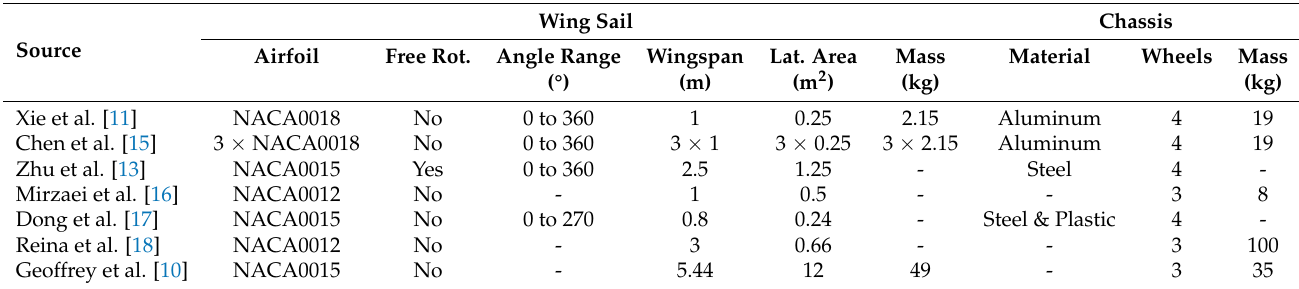
Table 1. Reviewed autonomous land